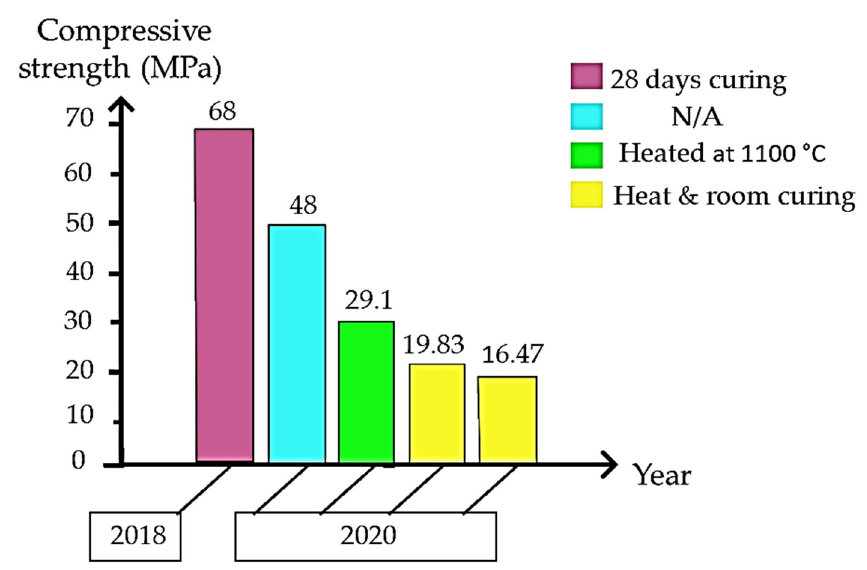
Figure 6. Reported compressive strength using kaolin.